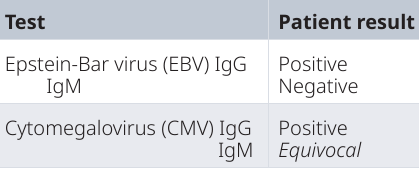
Table 4. Virology screening tests.